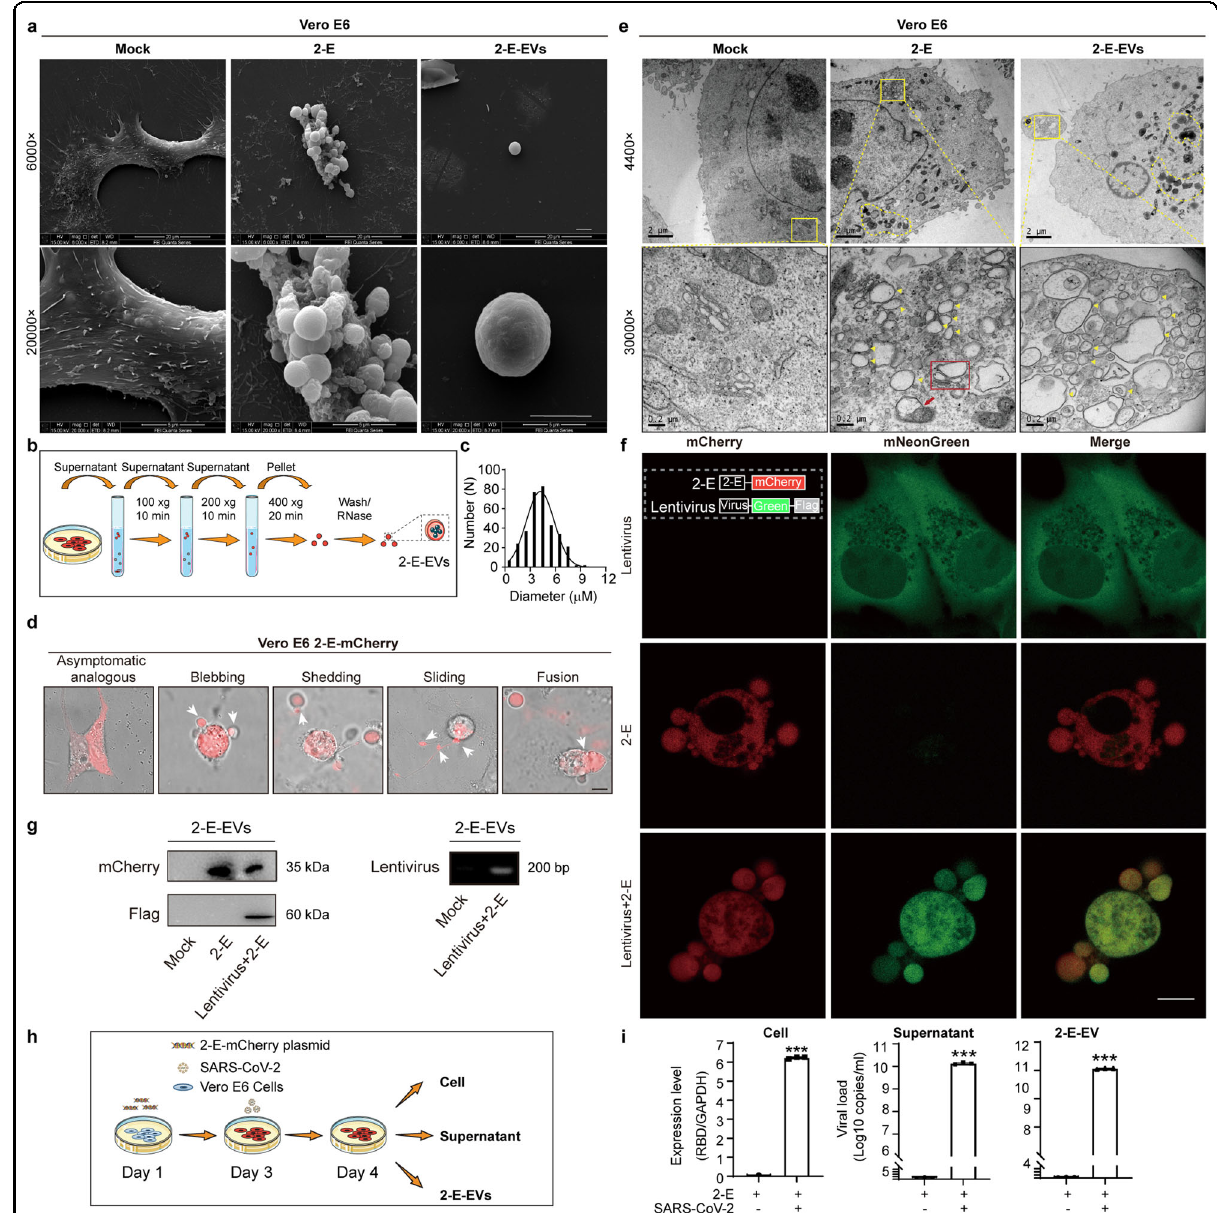
Fig. 1 The 2-E protein induces secretion of vesicles containing virus particles. a SEM images of 2-E-transfected Vero E6 cells and EVs isolated from the transfected cells. Scale bar, 5 μ m. b The fl ow chart showing the isolation of 2-E-EVs. c Diameter variation of 2-E-EVs. d Microscopy images of 2-E-mCherry-expressing Vero E6 cells during cell death. Five stages of 2-E-mCherry-transfected cells are shown. White arrows indicate 2-E-EVs. Scale bar, 10 μ m. e TEM images of 2-E-transfected Vero E6 cells and 2-E-EVs. Yellow triangles, SMVs; red box, swelling Golgi; red arrows, damaged mitochondria; yellow dotted circles, lysosomes. Scale bars, 2 μ m (up), 0.2 μ m (bottom). f Microscopy images of Vero E6 cells. The cells were infected with a lentivirus vector (Lenti-mNeonGreen-3×Flag) and then transfected with 2-E-mCherry plasmid to induce vesicles. Scale bar, 10 μ m. Illustration in the left corner shows a schematic view of the virus and plasmids used. An mCherry (red) and an mNeonGreen (green) tag were added to the C-termini of 2-E and lentivirus, respectively. g Left: immunoblot showing mCherry and Flag signals in isolated 2-E-EVs; all lanes were loaded with the same amount of total proteins. Right: nucleic acid gel image showing lentivirus in isolated 2-E-EVs. Shown is one representative experiment of three. h Schematic representation of infection experiments. Vero E6 cells were fi rst transfected with the 2-E-mCherry plasmid and then infected with SARS- CoV-2. The next day, the cells, supernatant and 2-E-EVs were collected. i qRT-PCR analysis of SARS-CoV-2 copies after transfection with the 2-E- mCherry plasmid and infection. The histograms show viral copies in cells (left), supernatant (middle), and isolated 2-E-EVs (right). Data are means ± SEM of at least three independent experiments. * P < 0.05, ** P < 0.01, *** P < 0.001; unpaired Student ’ s t